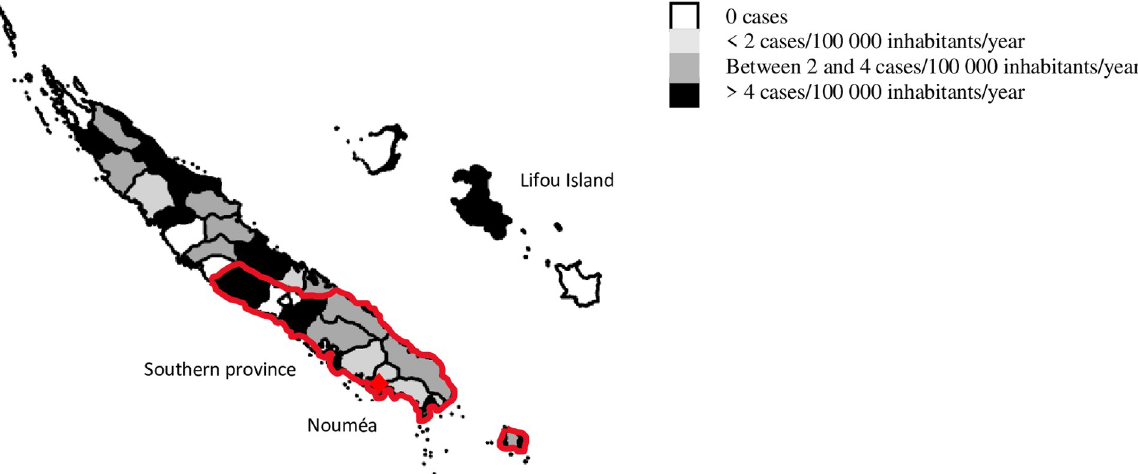
Fig 2. Map of the incidence of cases of EM in New Caledonia from 2004 to 2019, n = 92.